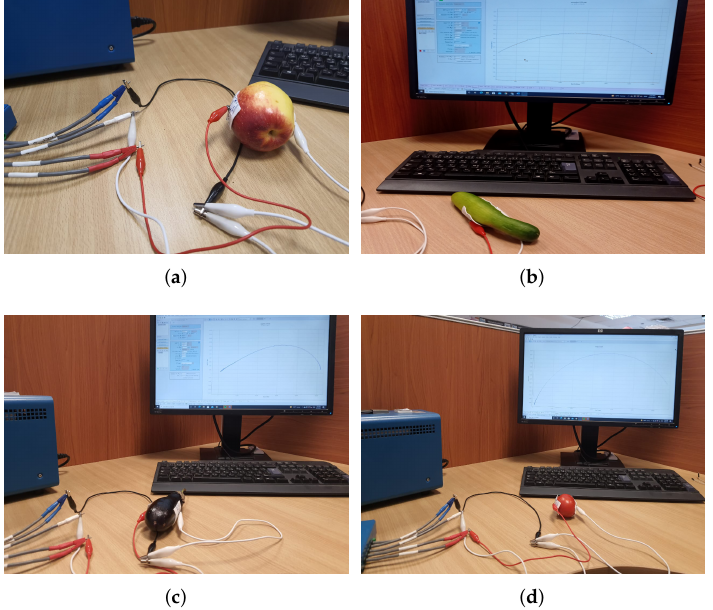
Figure 2. Experimental setup using the SP150 electrochemical station for measuring impedance data of four fruit samples: ( a ) apple; ( b ) cucumber; ( c ) eggplant; and ( d )